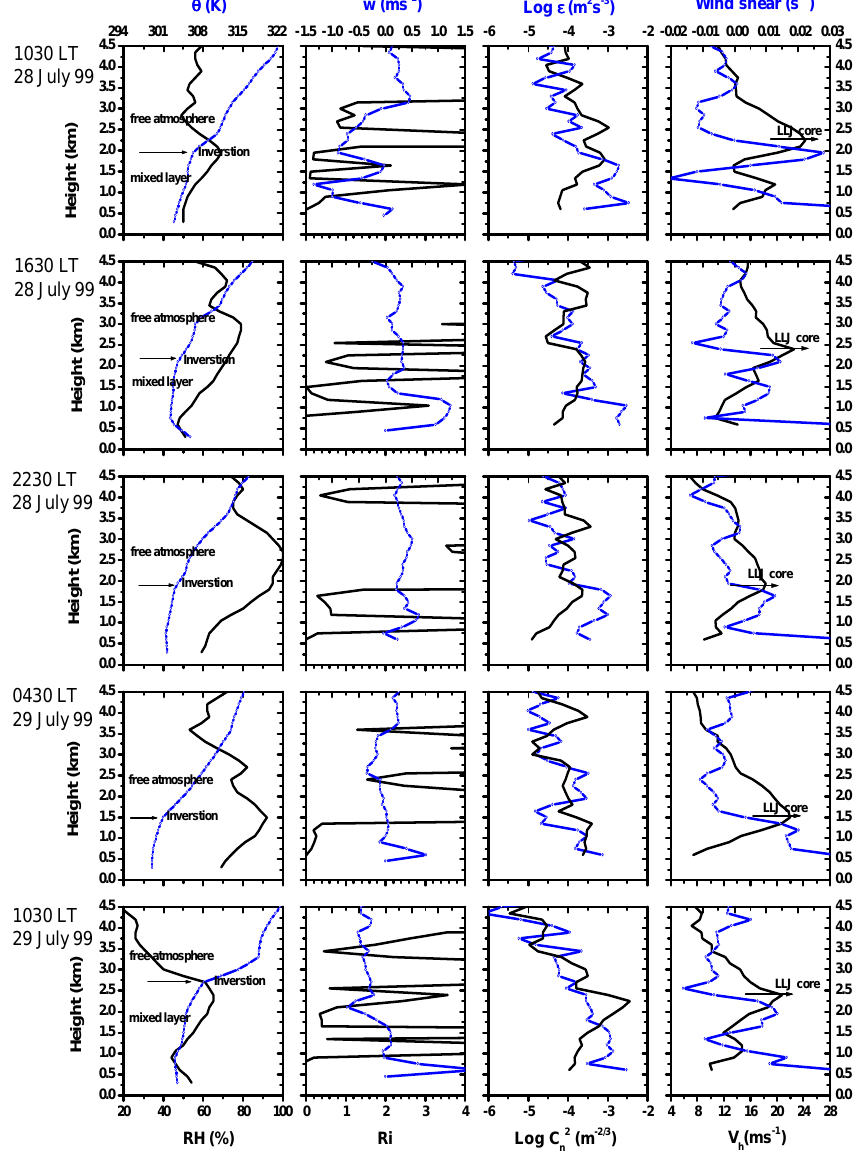
Fig. 5b. Height profiles of various parameters for every 6h interval from 10:30LT on 28 July 1999 to 10:30LT on 29 July 1999 can be seen from top to bottom row panels, respectively. Arrows indicate the height of the inversion layer and the LLJ core.